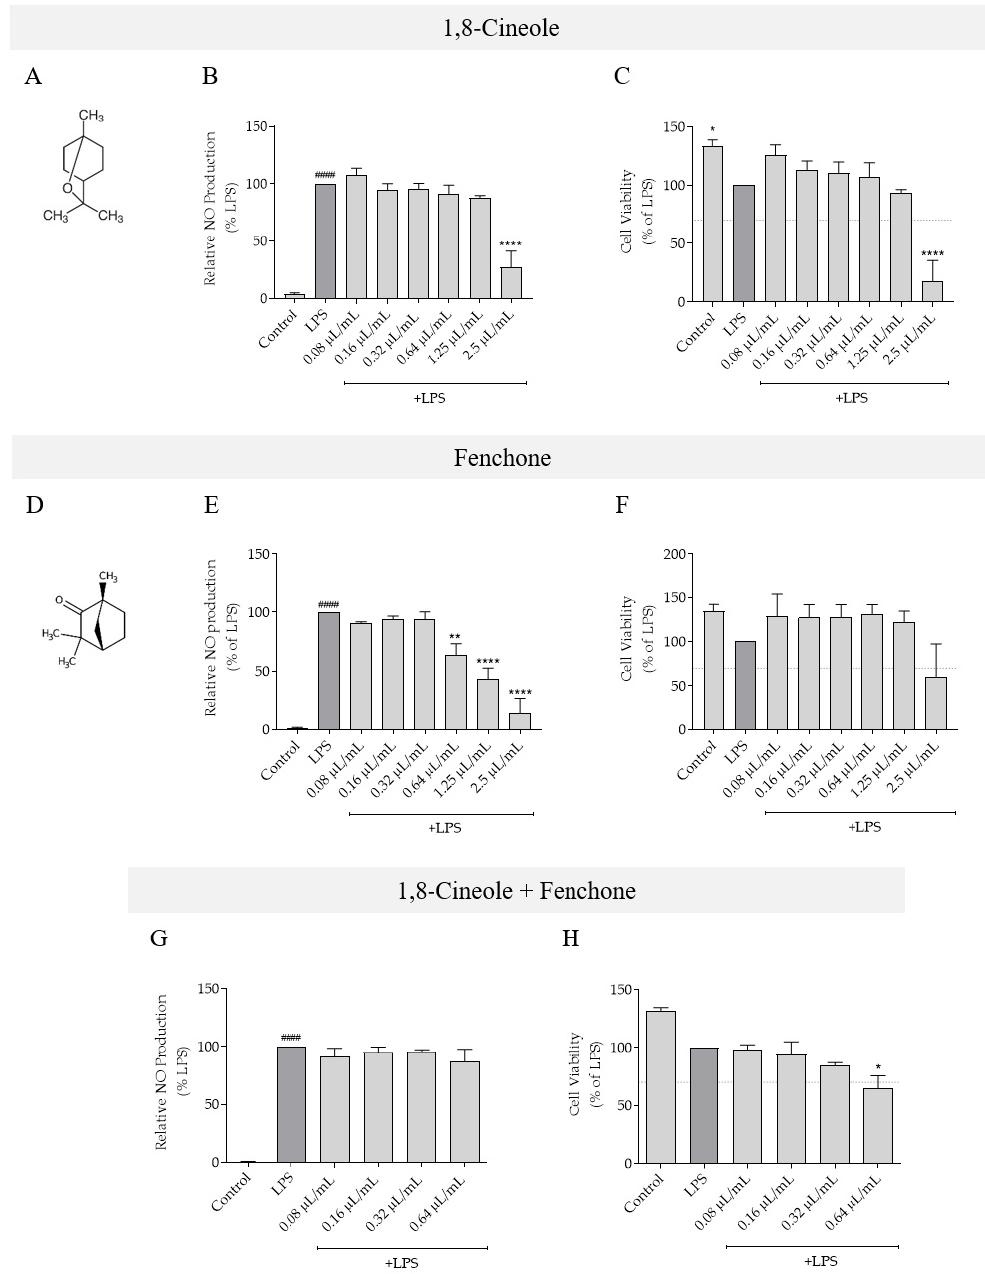
Figure 4. Effect of 1,8-cineole, fenchone, and their mixture on NO production. Chemical structure of ( A ) 1,8-cineole and ( D ) fenchone. Effect of 1,8-cineole ( B , C ), fenchone ( E , F ) and 1,8-cineole combined with fenchone ( G , H ) on NO production and cell viability, respectively. Cells were maintained in culture medium (control), or incubated with 1 µ g/mL LPS, or with LPS in the presence of different concentrations of the compounds (0.08– 2.5 µ L/mL), for 24 h. Nitrite concentration was determined from a sodium nitrite standard curve and the results are expressed as a percentage of NO production by cells treated with LPS. Cell viability results are expressed as percentage of MTT reduction by cells treated with LPS. Each value represents the mean ± SEM of three experiments, performed in duplicate (#### p < 0.0001, compared to control; * p < 0.05, ** p < 0.01 and **** p < 0.0001, compared to LPS). The dotted line in cell viability graphs represents the threshold (70% of maximal viability) below which cytotoxicity is recognized, in agreement with standard ISO 10993-5